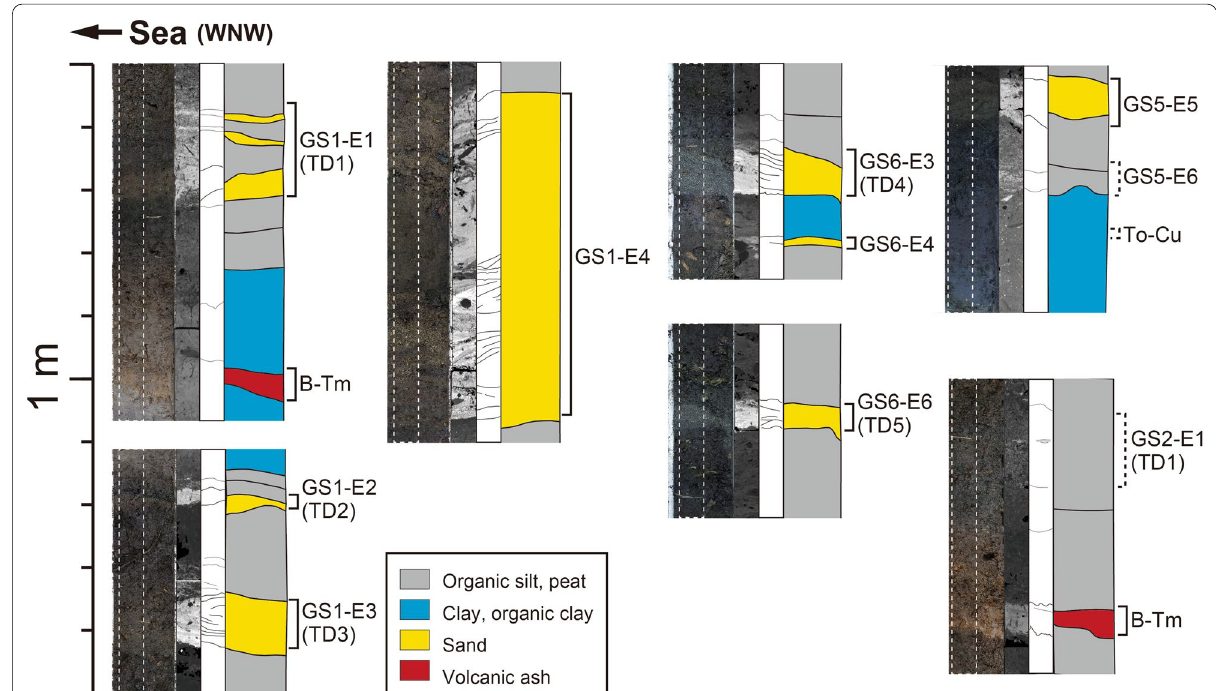
Fig. 6 Close-up images and description of event deposits in SKN-GS cores. White dashed line shows the extent of the XCT